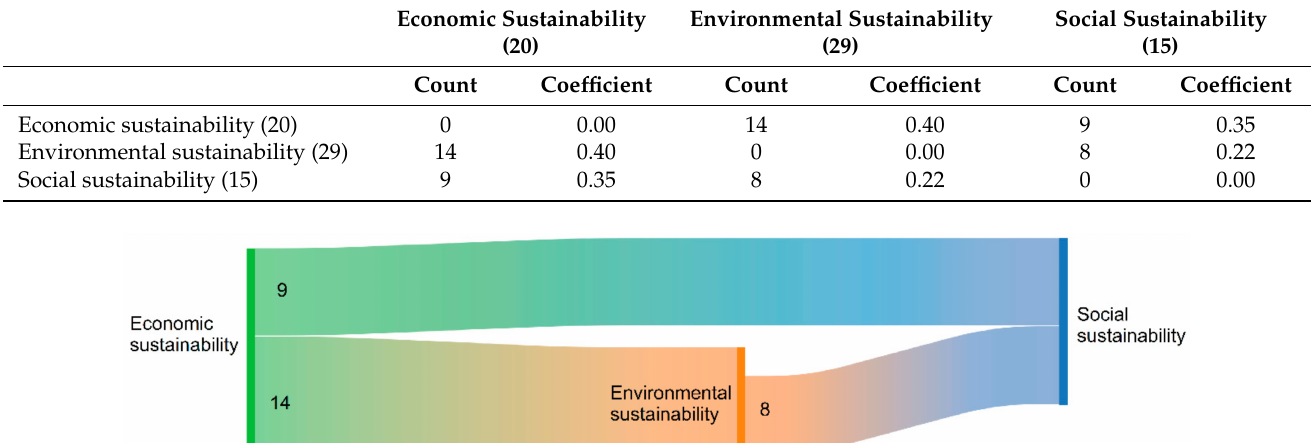
Table 2. Co-occurrences between the findings considered advances in the sustainability category from the review of scientific articles on multi-story timber buildings.